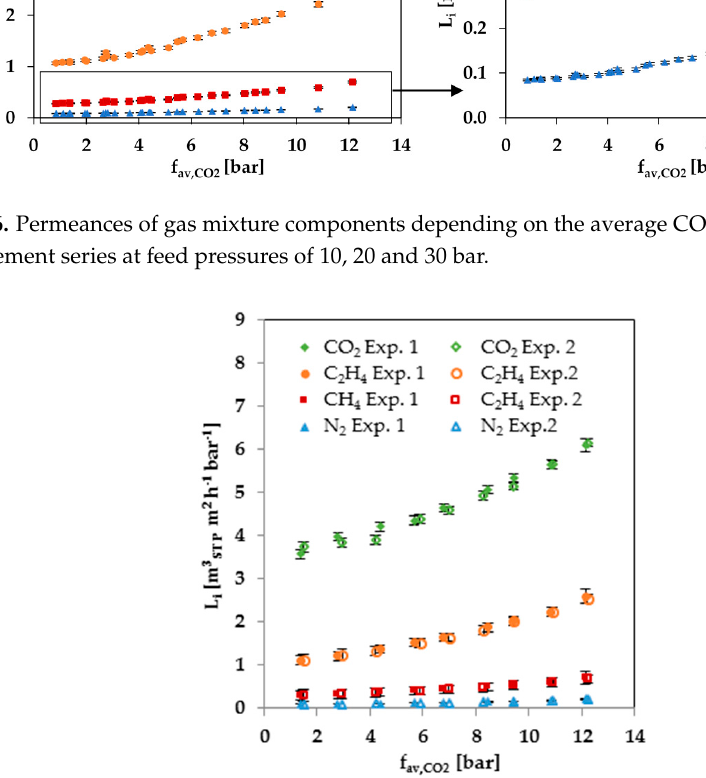
Figure 8. Comparison of measured data (Exp.) with simulated data (Sim.) for CO 2 permeance at 25 °C plotted against average CO 2 fugacity: ( a ) Simulation data based on FVM parameters determined from low pressure (up to 2 bar) single gas data; ( b ) Simulation data based on FVM parameters determined from high pressure (2 to 30 bar) single gas data.